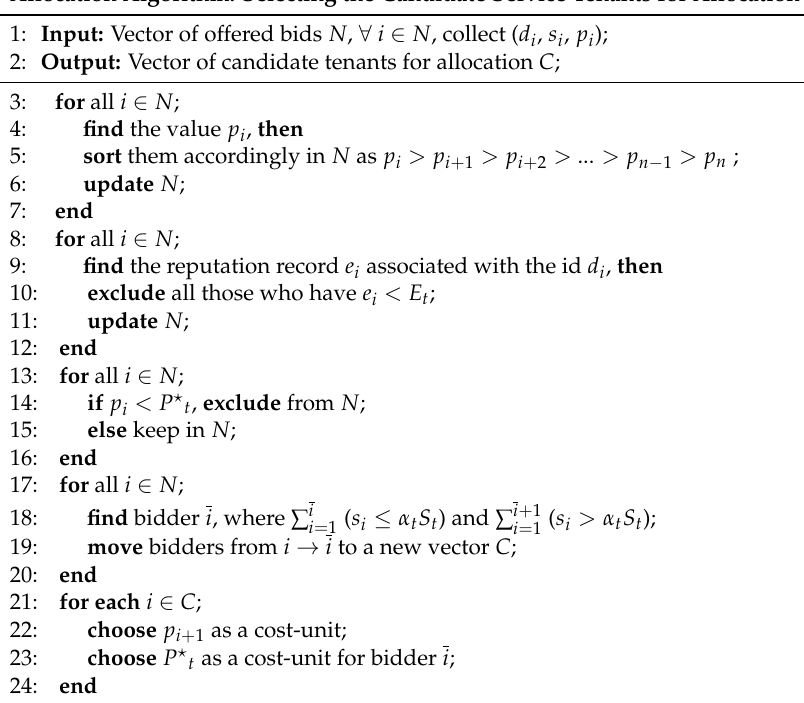
Table 1. ARAAC’s Allocation